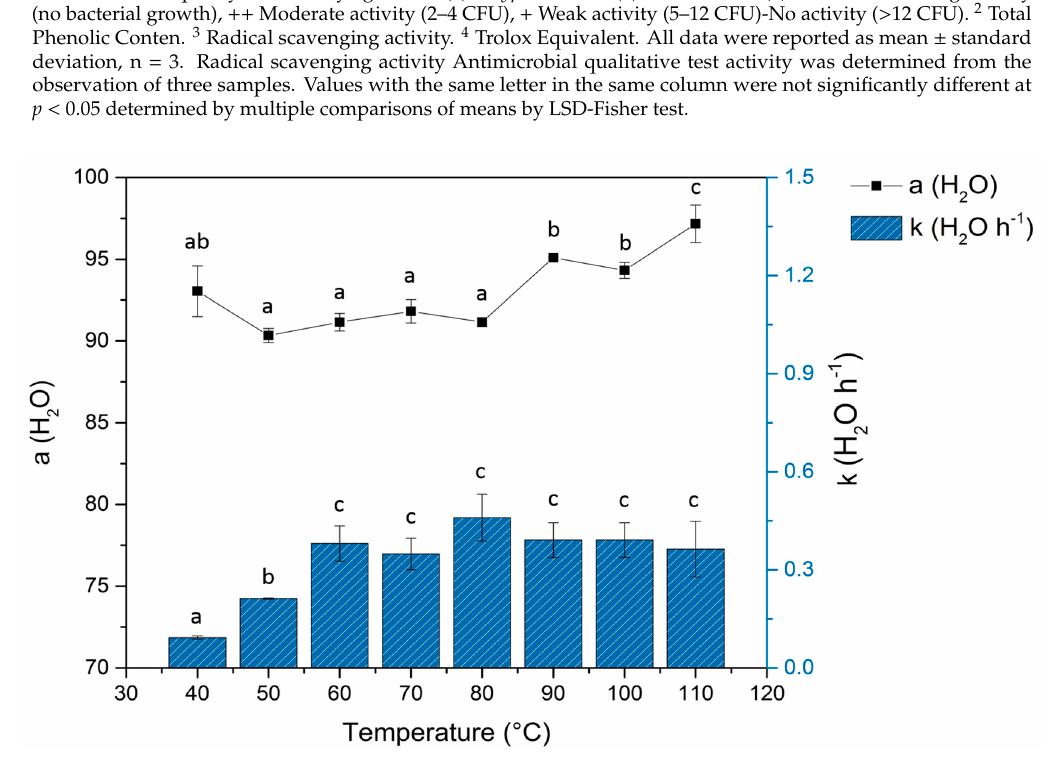
Figure 1. The kinetic parameters of drying lemon residues estimated by Gompertz model.